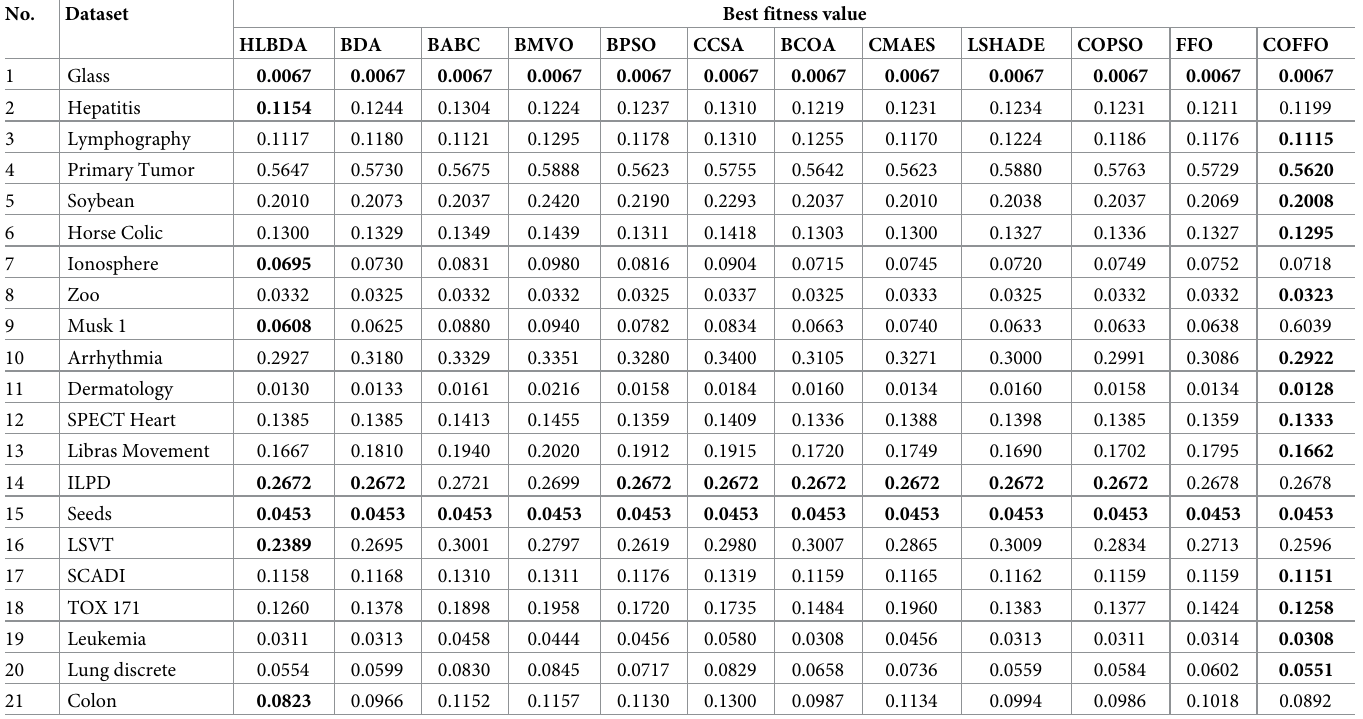
Table 9. Best fitness value results for tested